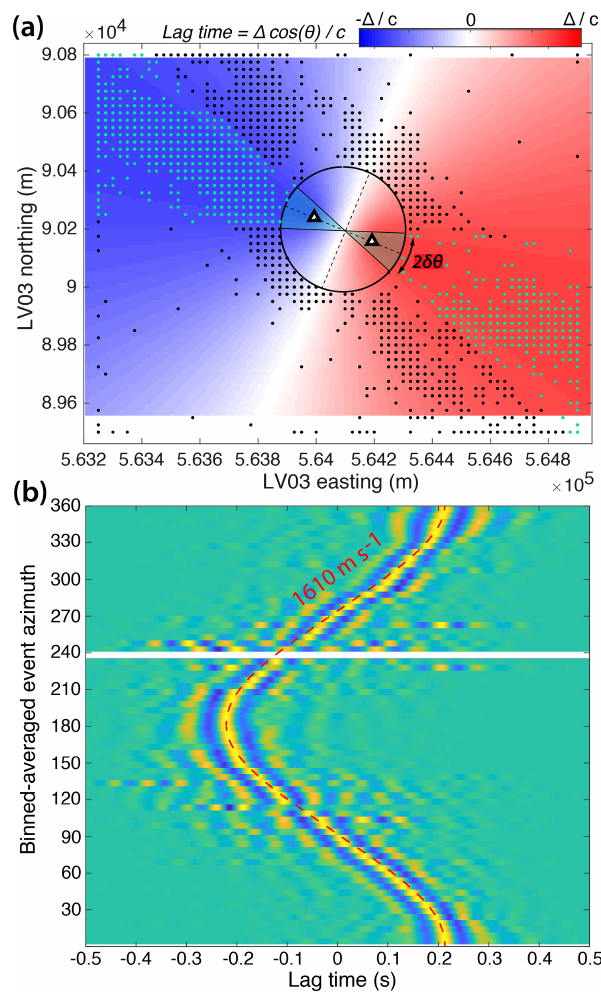
Figure B4. (a) Icequake locations (dots) in Glacier d’Argentière whose waveforms are cross-correlated at the two stations (triangles) to obtain (b) . Green dots in (a) show the events that lie in the end- fire lobes of aperture 2 δθ (see main text). (b) The icequake cross- correlation functions (here averaged in 5 ◦ azimuth bins) give co- herent arrival times for Rayleigh waves traveling in the ice between the two stations, which are a function of the inter-station distance (cid:49) and the event azimuth relative to the station path θ , as plotted in background colors in (a) . The red dashed line shows the least- square fit of the arrival times with a sinusoidal function of phase velocity c = 1610ms − 1 for a central frequency of 15Hz. Correla- tion functions are here filtered between 10 and